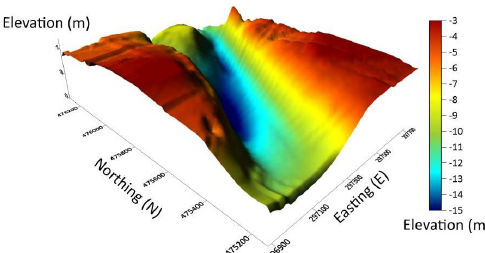
Figure 18. A 3D bathymetric plan relative to the on-site tide gauge in 2018